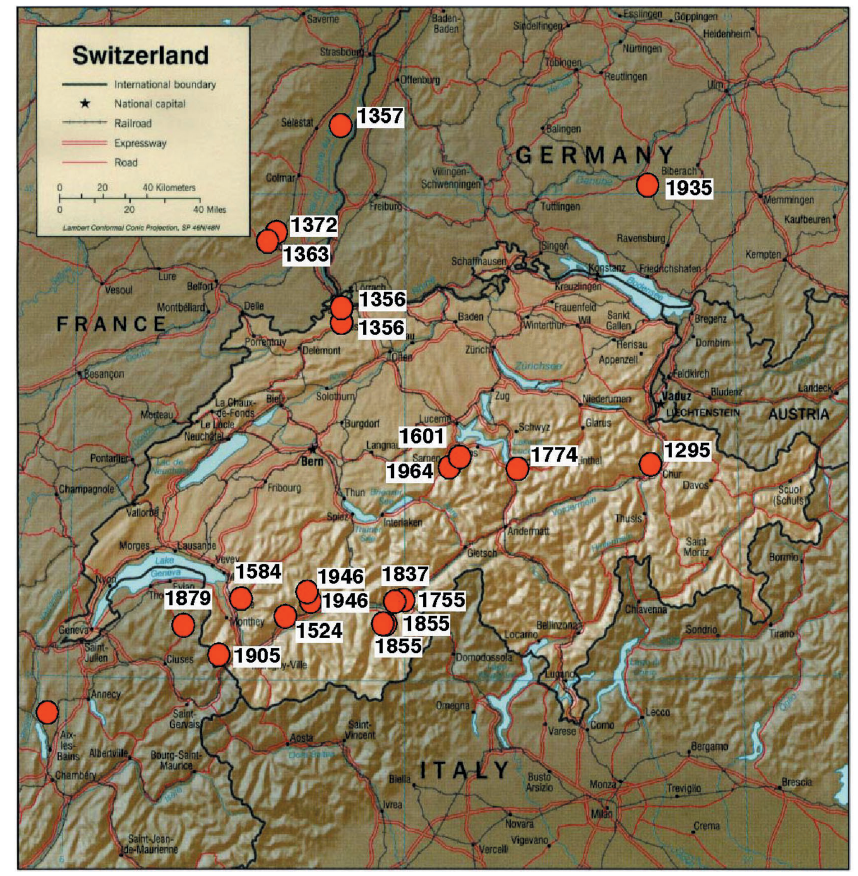
Fig. 2. Epicenter map of Swiss earthquakes 1200-2000 with I o ≥ VII (EMS-98) or M w ≥ 5, including border- ing